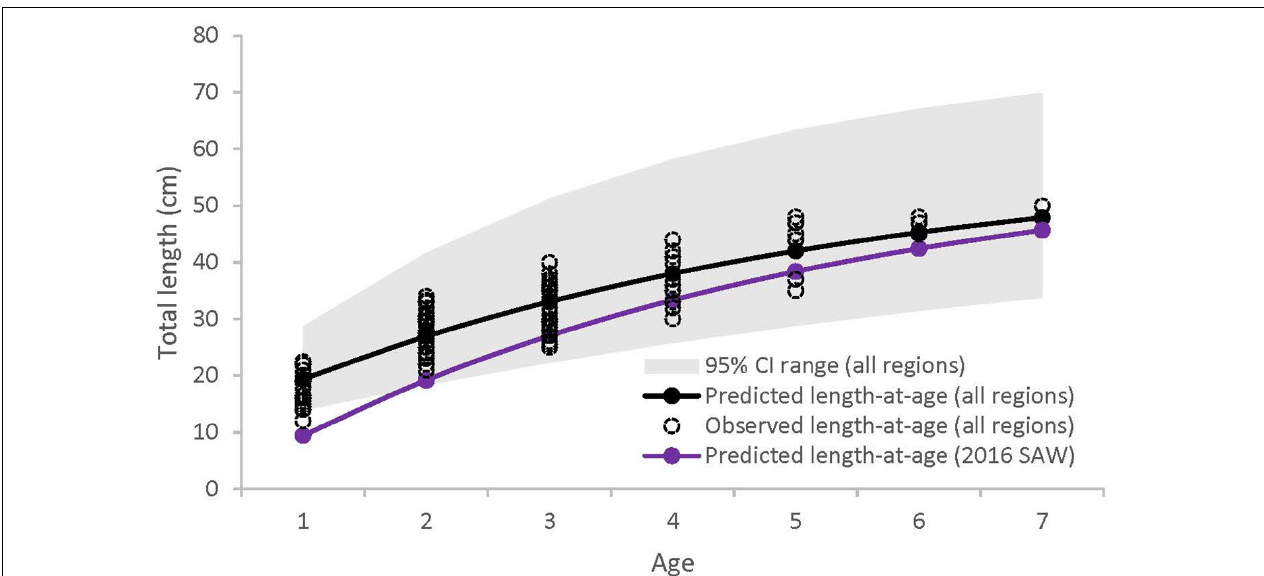
FIGURE 3 | Von Bertalanffy growth curves for black sea bass from all regions combined (black), and from the 2016 Black Sea Bass Stock Assessment (purple) (Northeast Fisheries Science Center [NEFSC], 2016). Gray shaded area represents 95% confidence intervals for all regions combined (95% confidence intervals not available for 2016 Black Sea Bass Stock Assessment).